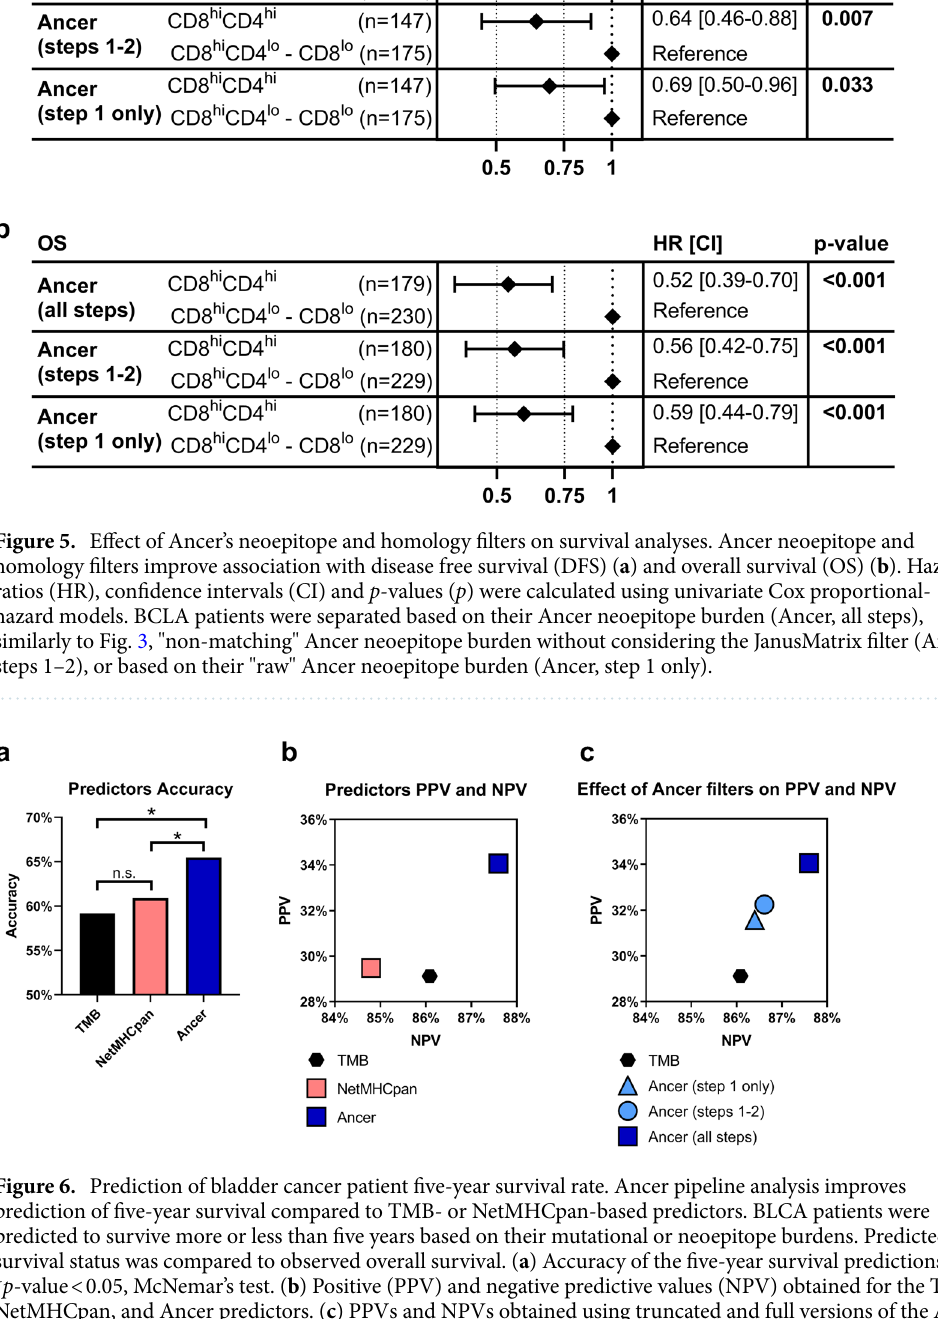
For the cohort of 220 bladder cancer patients with known five-year OS outcomes, Ancer neoepitope burden, as determined by the full Ancer pipeline, was a more accurate predictor of five-year survival (Fig. 6a, 65% accu- racy) than TMB (59% accuracy) or NetMHCpan neoepitope burden (61% accuracy). The Ancer analysis also achieved higher Positive Predictive Value (PPV) and Negative Predictive Value (NPV) statistics (PPV = 34%, NPV = 88%) as compared to TMB- (PPV = 29%, NPV = 86%) or NetMHCpan-based predictors (PPV = 29%,